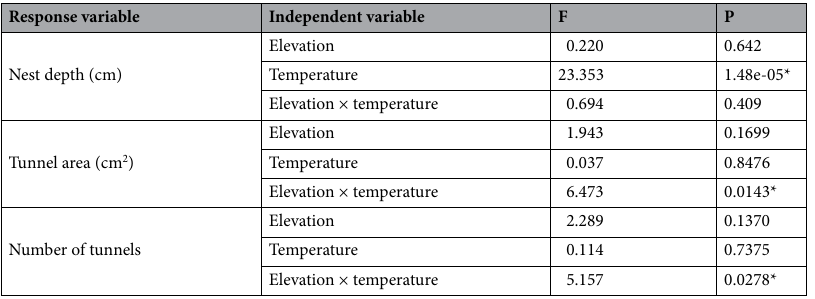
Table 1. Two-way ANOVA results for Day 7 (fully excavated) nests. Nest depth differed significantly between temperature treatments. There was a significant interaction effect between temperature treatment and natal elevation for both tunnel area and the number of tunnels. Df = 1,47. *Significant, ⍺ =